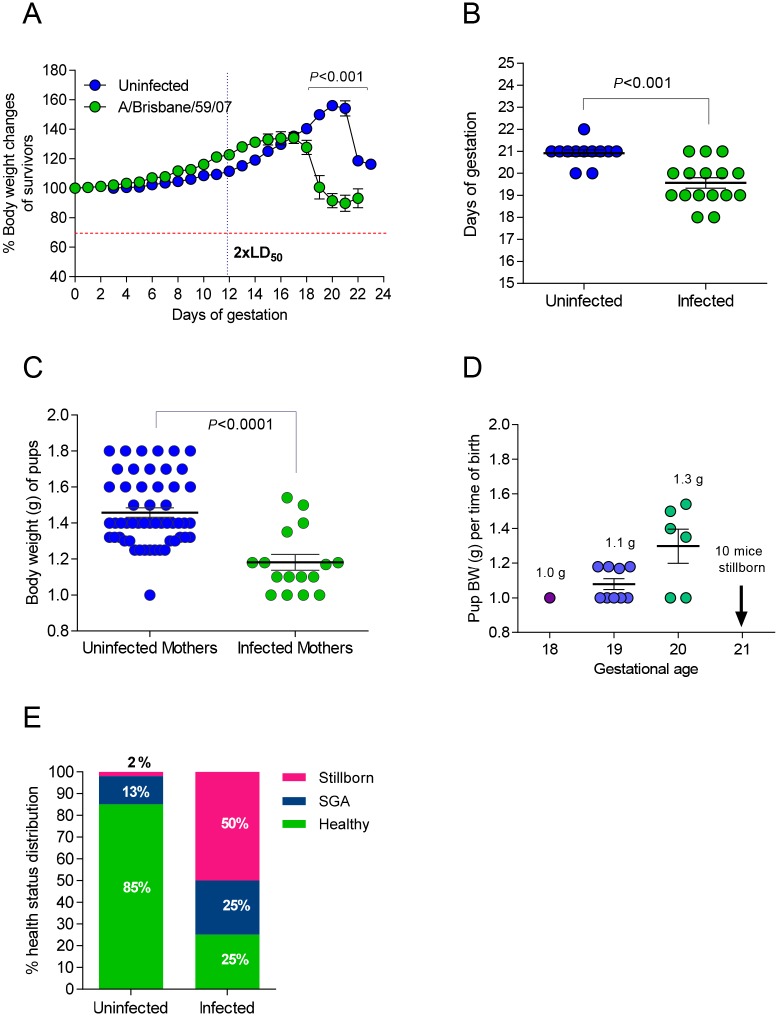
Influenza infection inhibits gestational development and offspring health.(A) Body weight (BW) fluctuations of pregnant BALB/c mice were tracked over the course of gestation. At day 12 of gestation (dashed vertical line) a cohort of pregnant mice (N = 6) was infected with 2xLD50 A/Brisbane/59/07. Weight changes were compared to uninfected pregnant controls (N = 12). P-values were calculated by two-way ANOVA. Error bars represent Standard Error of Mean (SEM). (B) Mean gestational length for infected (N = 13) and uninfected (N = 9) groups was calculated based on the dates of successful copulation and parturition of offspring. P-value was calculated by Student’s t-test. (C) The body weights (BW) of pups born to infected (N = 16 to 6 mothers) and uninfected mothers (N = 53 to 12 mothers) were recorded upon delivery. (D) The BW distribution of pups was categorized based on gestational age. Pups less than 1.25g were designated SGA. Pups greater than 1.25g were considered healthy. Average BW and SEM were plotted and P = value was calculated by Student’s t-test for C and D. (E) Percent distribution of health status of pups born to uninfected and infected mothers.